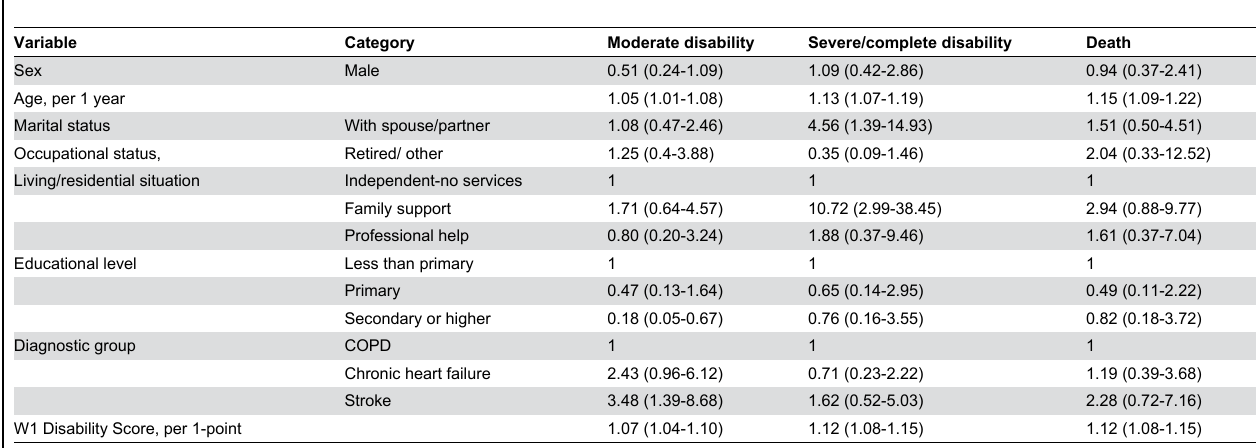
Table 4. Outcome relative risk ratios from multinomial models.